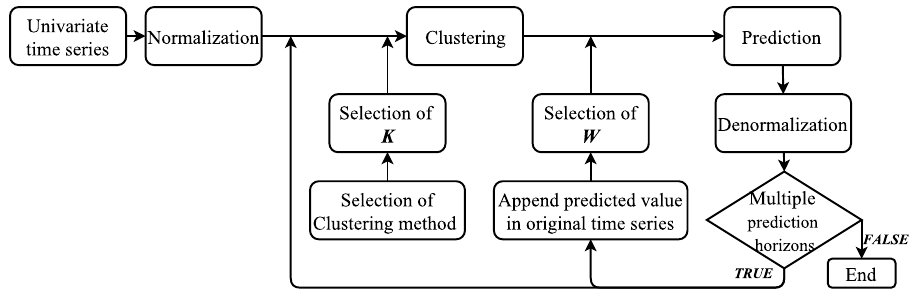
Figure 1. Steps involved in PSF